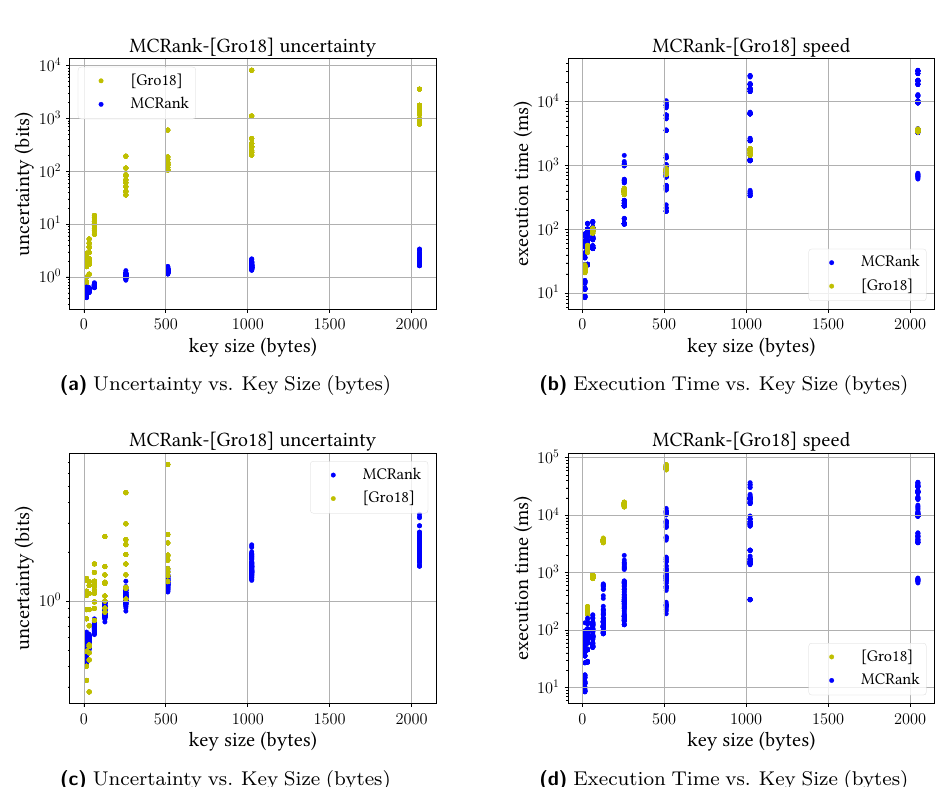
Figure 5: RSA key-load attack. Comparison with CARDIS18 [Gro18]. MCRank has lower (i.e., better) uncertainty (a) for similar execution speed (b). For similar accuracy (c), MCRank is faster (d). For keys larger than 512 bytes, CARDIS18 cannot achieve the same accuracy as MCRank because, due to the large number of bins, the program exceeds the memory limits and is killed by the operating